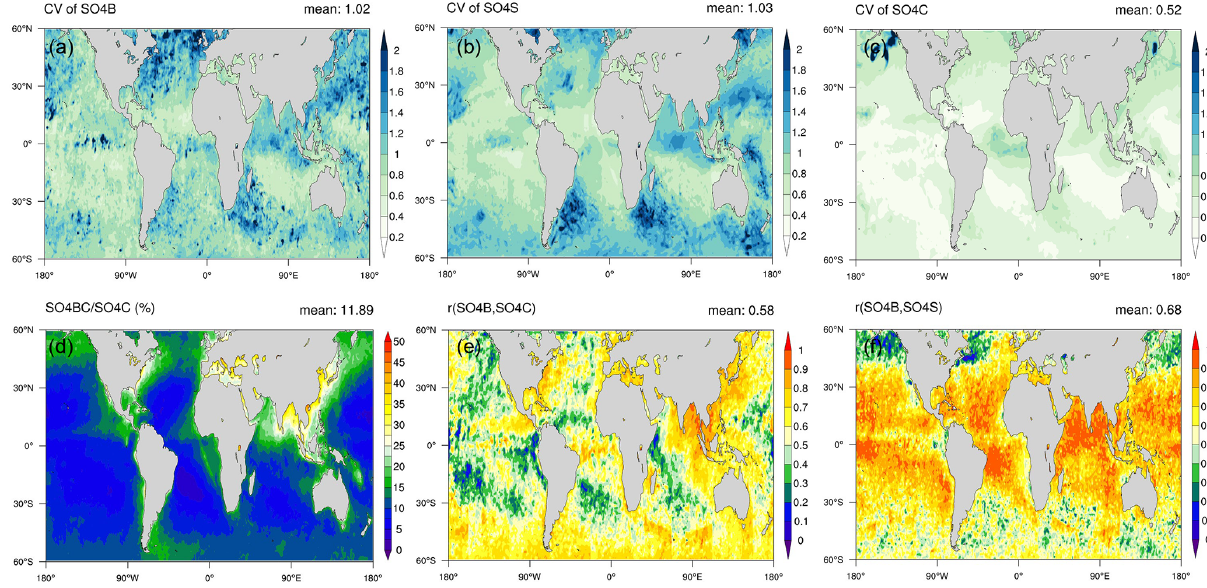
Figure 8. Map of coefficients of variation (CV) of (a) SO 4 B, (b) SO 4 S, and (c) SO 4 C, (d) the ratio of column mass of SO 4 below clouds (SO 4 BC) to SO 4 C (%) and Pearson’s correlation coefficients of SO 4 B with (e) SO 4 C and (f) SO 4 S, which are calculated for each 1 ◦ × 1 ◦ grid box over the period of